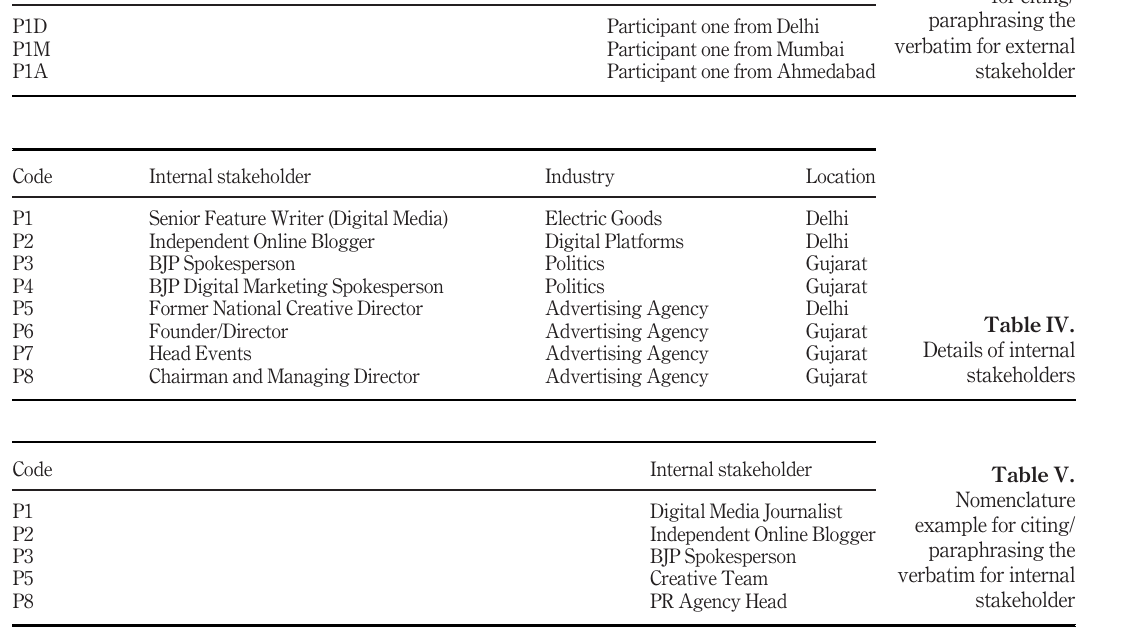
Table III. Nomenclature used